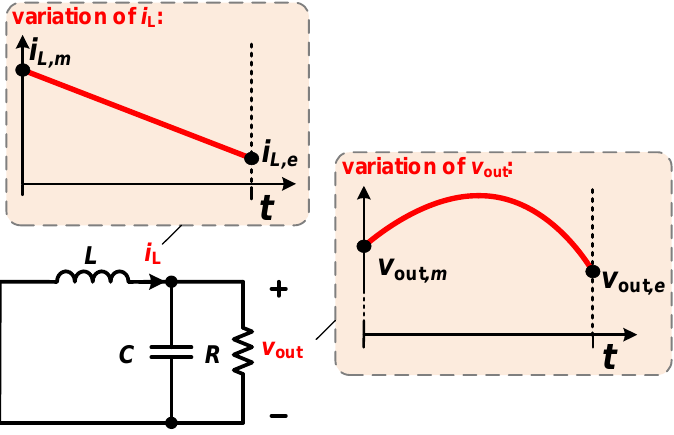
Figure 4. Equivalent circuit scheme and state variations of the buck converter during switching-OFF.